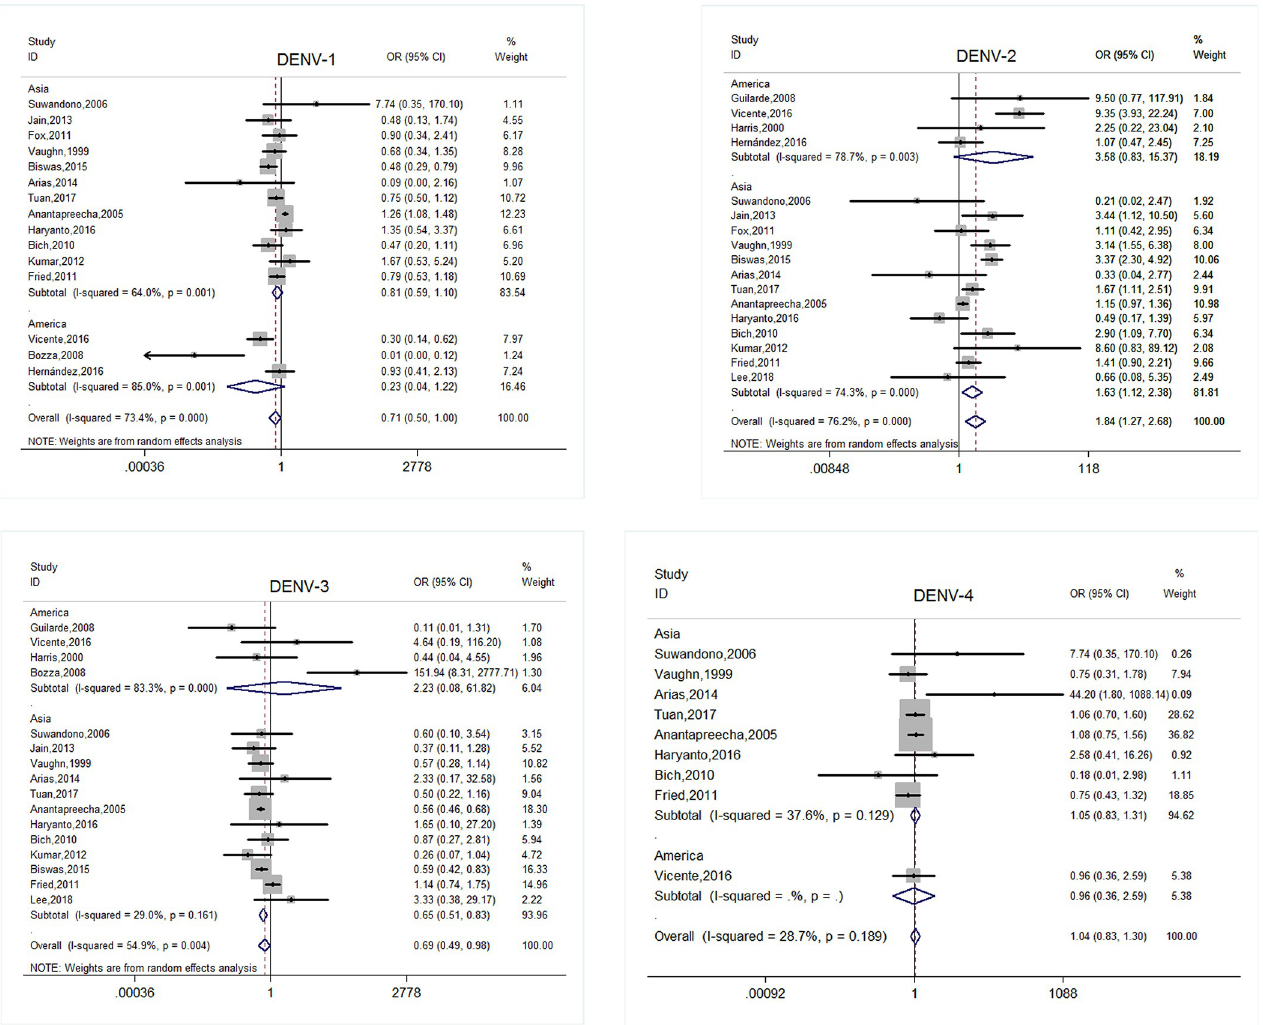
Fig 2. Forest plot of the subgroup analysis of the area of origin for serotypes of DENV (DF vs SD, OR = odds ratio). A: DENV-1; B: DENV-2; C: DENV-3; D: DENV-4.